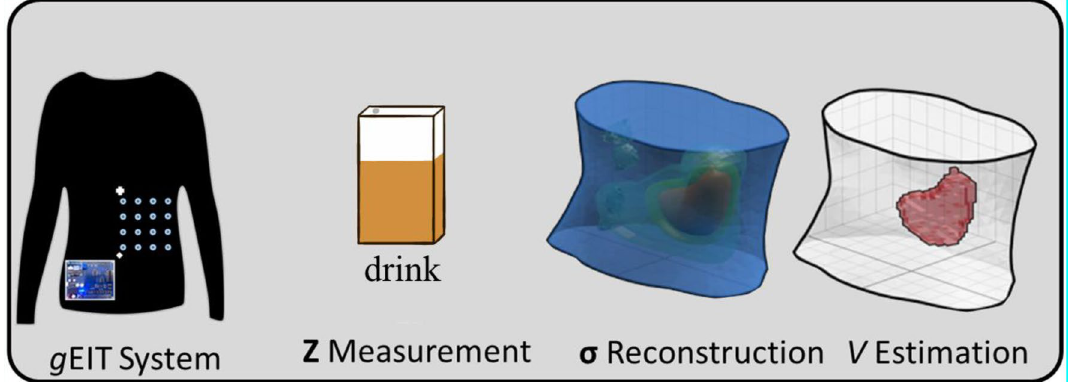
Figure 2. Overview of gastric content volume V estimation by g EIT Suit with dual-step fuzzy clustering.